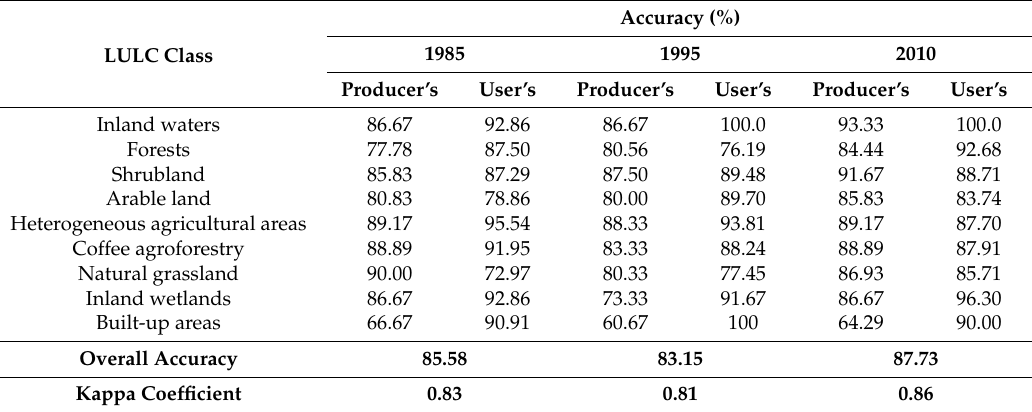
Table 3. Accuracy assessment of classified